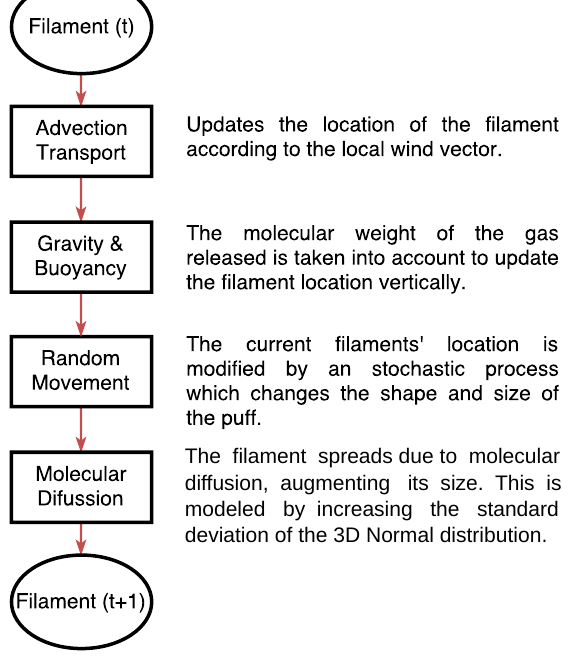
Figure 5. On each iteration, the location and shape of filaments are updated according to four dispersion phenomena: advection, gravity, randomness and